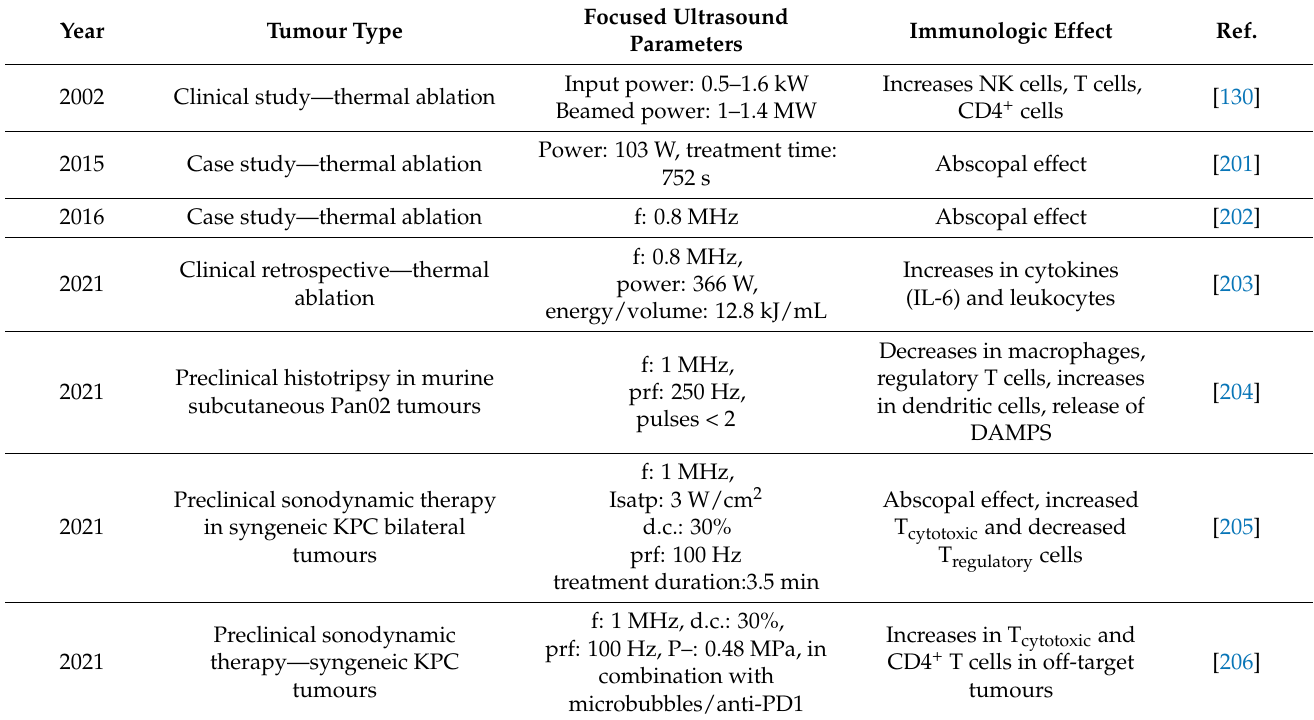
Table 3. Complete list of published studies showing the immunological effects of therapeutic focused ultrasound in pancreatic